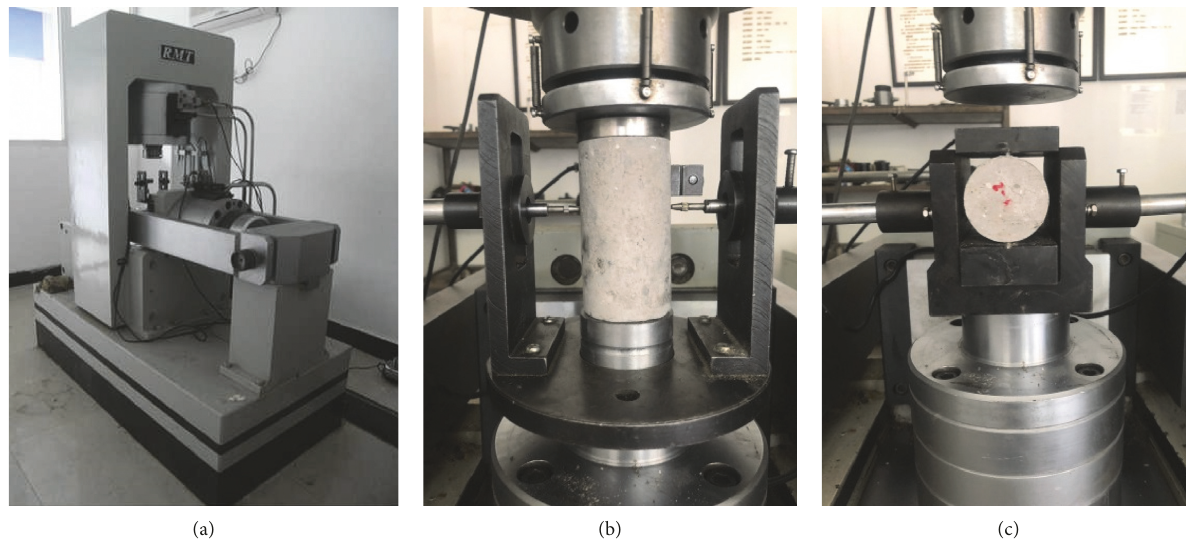
Figure 4: Uniaxial compression test and the splitting tensile testing devices: (a) RMT-150C rock mechanics test system; (b) uniaxial compression loading device; (c) splitting tensile loading device.